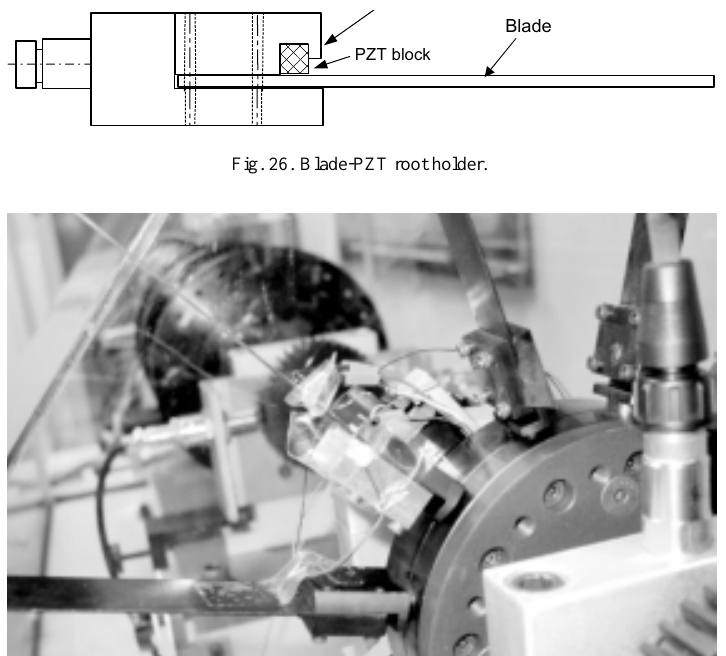
Fig. 27. Photograph of the blade-PZT root